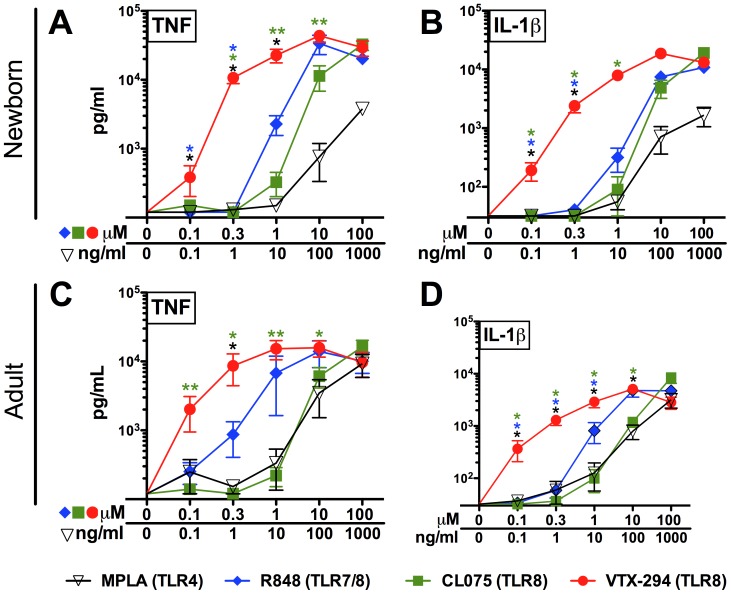
VTX-294 is more potent and effective than R-848 in inducing TNF and IL-1β in whole blood.Human neonatal and adult blood was cultured for 6 h with MPLA (TLR4), R848 (TLR7/8), CL075 (TLR8) and VTX-294 (TLR8) and supernatants collected for TNF or IL-1β ELISA. Compound concentrations are shown in µM, except for MPLA, which are shown in ng/ml. Data are shown as mean ± SEM of n = 5–8. For between-group analyses, Wilcoxon signed-rank test was applied to compare VTX-294 median value to the other compounds at a given concentration. Statistical significance is denoted as follows: *p<0.05 and **p<0.01, with black star(s) for comparison to MPLA, blue star(s) for comparison to R848 and green star(s) for comparison to CL075.